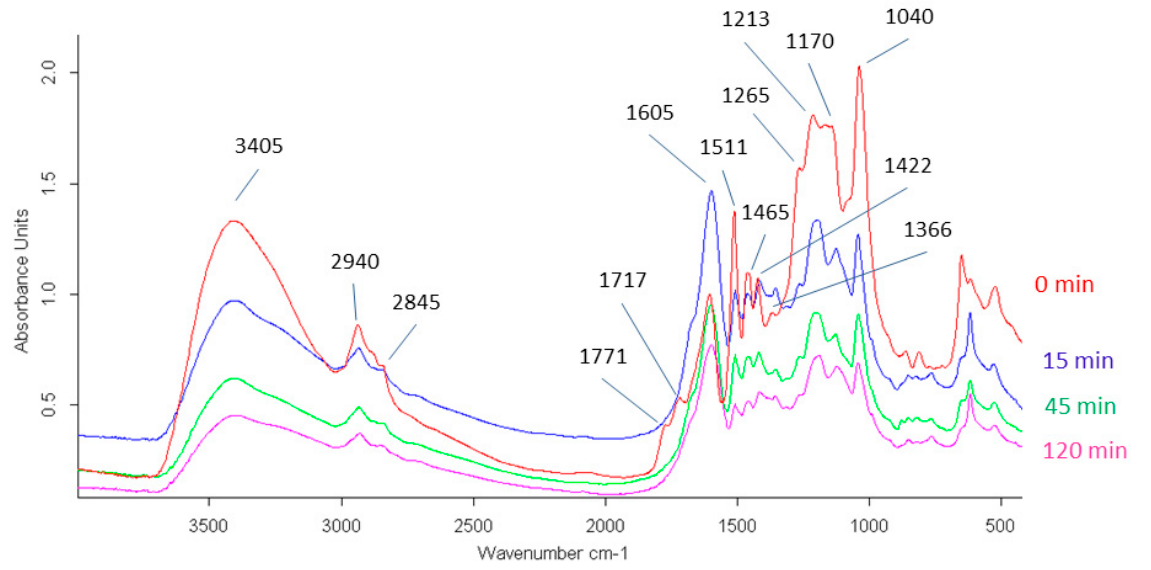
Figure 4. FTIR-spectra of LH, sampled at different processing time.